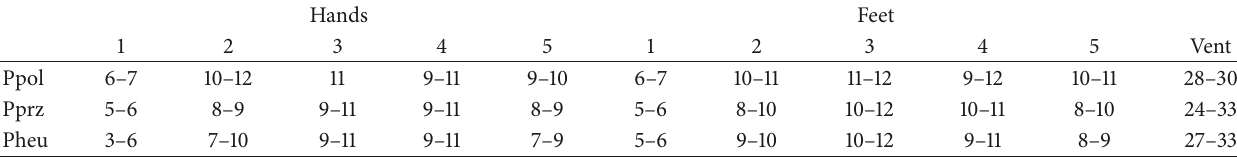
Table 1: Morphological variation among Phyllopezus heuteri , P. pollicaris , and P. przewalskii . Hands Feet